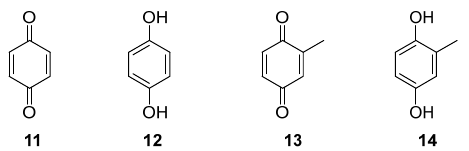
Figure 5. Parent benzo- and hydroquinones 11 – 14 .